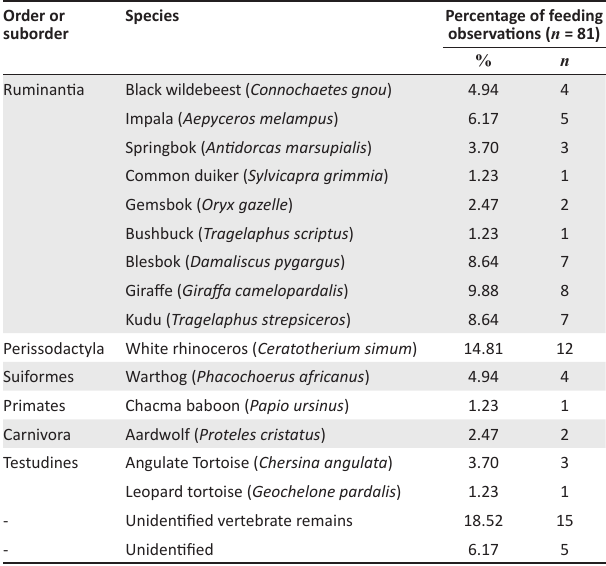
Order or suborder